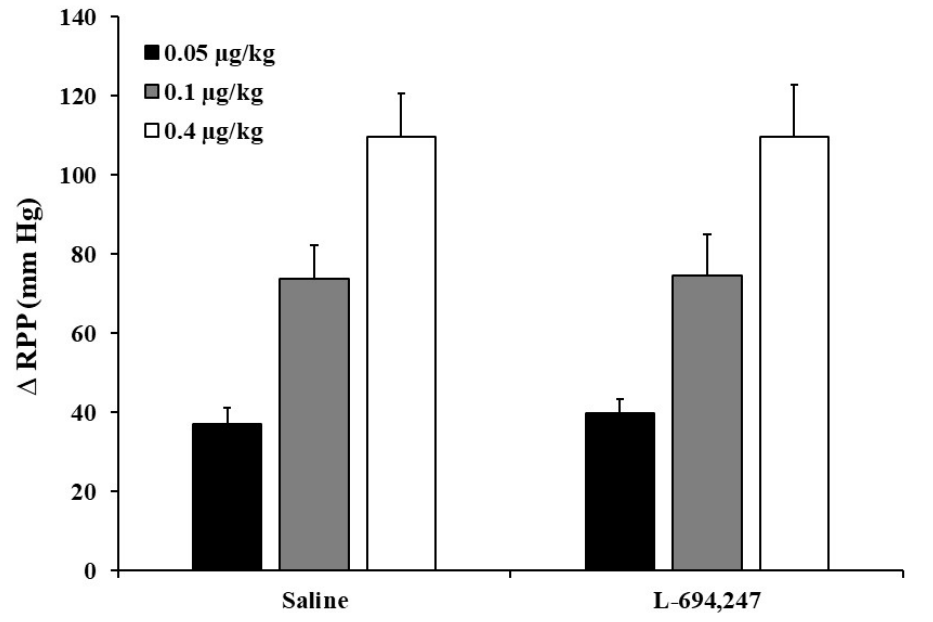
Figure 5. Effect of L-694,247 on the noradrenaline-induced increases in renal perfusion pressure in diabetic rats. Effect of i.a. bolus injections of saline (10 µ L) or L-694,247 (0.4 µ g/kg) on the increases in renal perfusion pressure ( ∆ RPP) evoked by i.a. administration of exogenous noradrenaline (0.05, 0.1 and 0.4 µ g/kg) in the in situ-autoperfused kidney of diabetic rats. No statistical